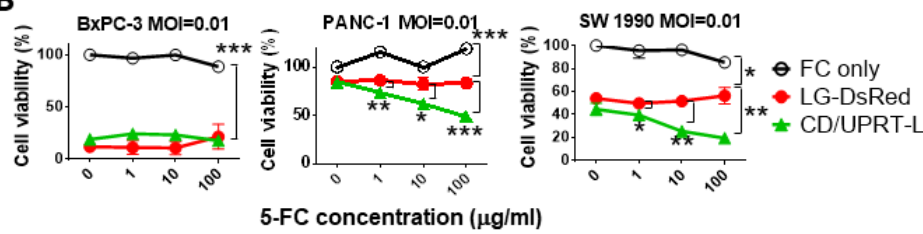
Figure 3. Cell viability tests show cytotoxicity with mitogen-activated protein kinase-dependent recombinant vaccinia virus (MDRVV) alone or in combination with armed MDRVV and 5- fluorocytosine (5-FC) in human pancreatic ductal adenocarcinoma cell lines. ( A ) Pancreatic cancer cell lines were infected with each recombinant virus at a multiplicity of infection (MOI) of 0.1, and 48 h later. Cells were treated with 0, 1, 10, or 100 µ g/mL of 5-FC. Cell viabilities were determined 120 h after virus infection. ( B ) BxPC-3, PANC-1, and SW 1990 cells were infected with each recombinant virus at an MOI of 0.01 and combined with 5-FC as described in ( A ). Data are presented as the mean ± SD (n = 3). * p < 0.05, ** p < 0.01, *** p < 0.001 (two-tailed unpaired t-test).